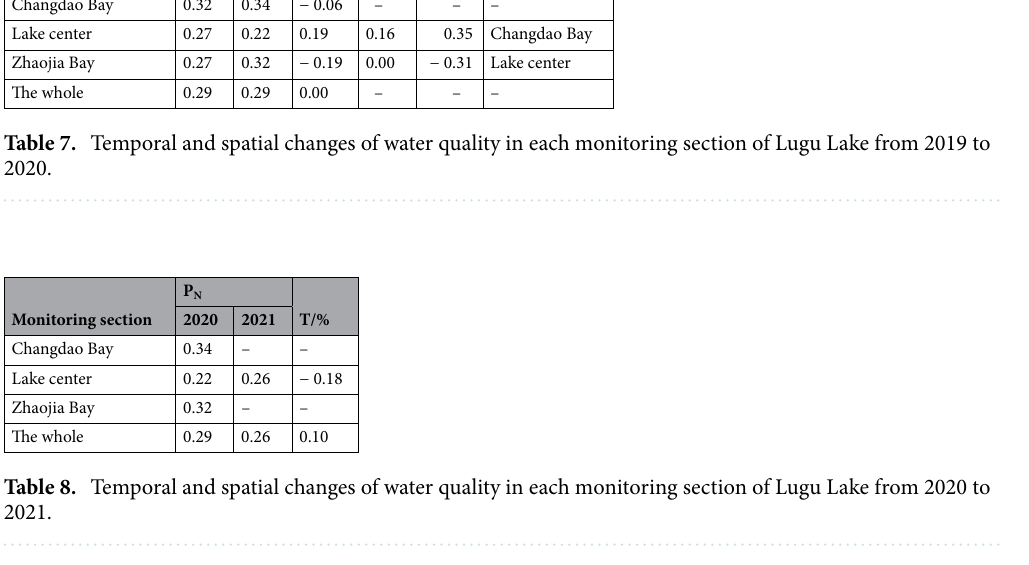
Monitoring section